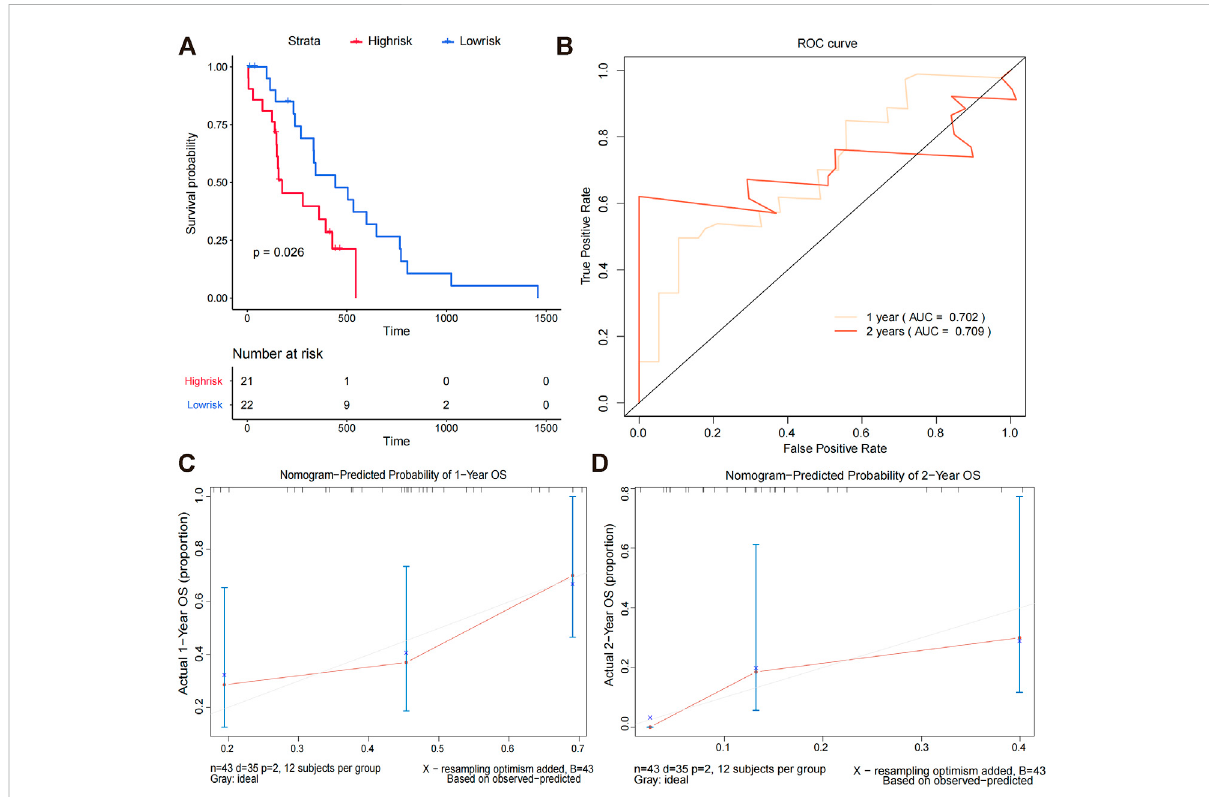
FIGURE 5 Nomogram prediction model evaluation. (A) Difference in theoverall survival between high-risk and low-risk groups. (B) We evaluated theAUC values at 1 and 2 years based on time-dependent ROC curves for the overall survival of the validation set. (C,D) Calibration curves for predicting the overall survival in the validation set at 1 and 2